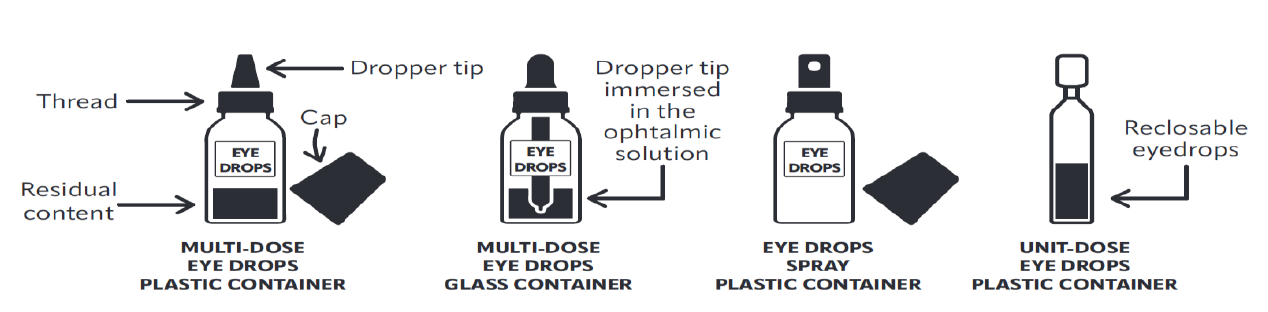
Figure 1. Frequent types of in-use eye drops.